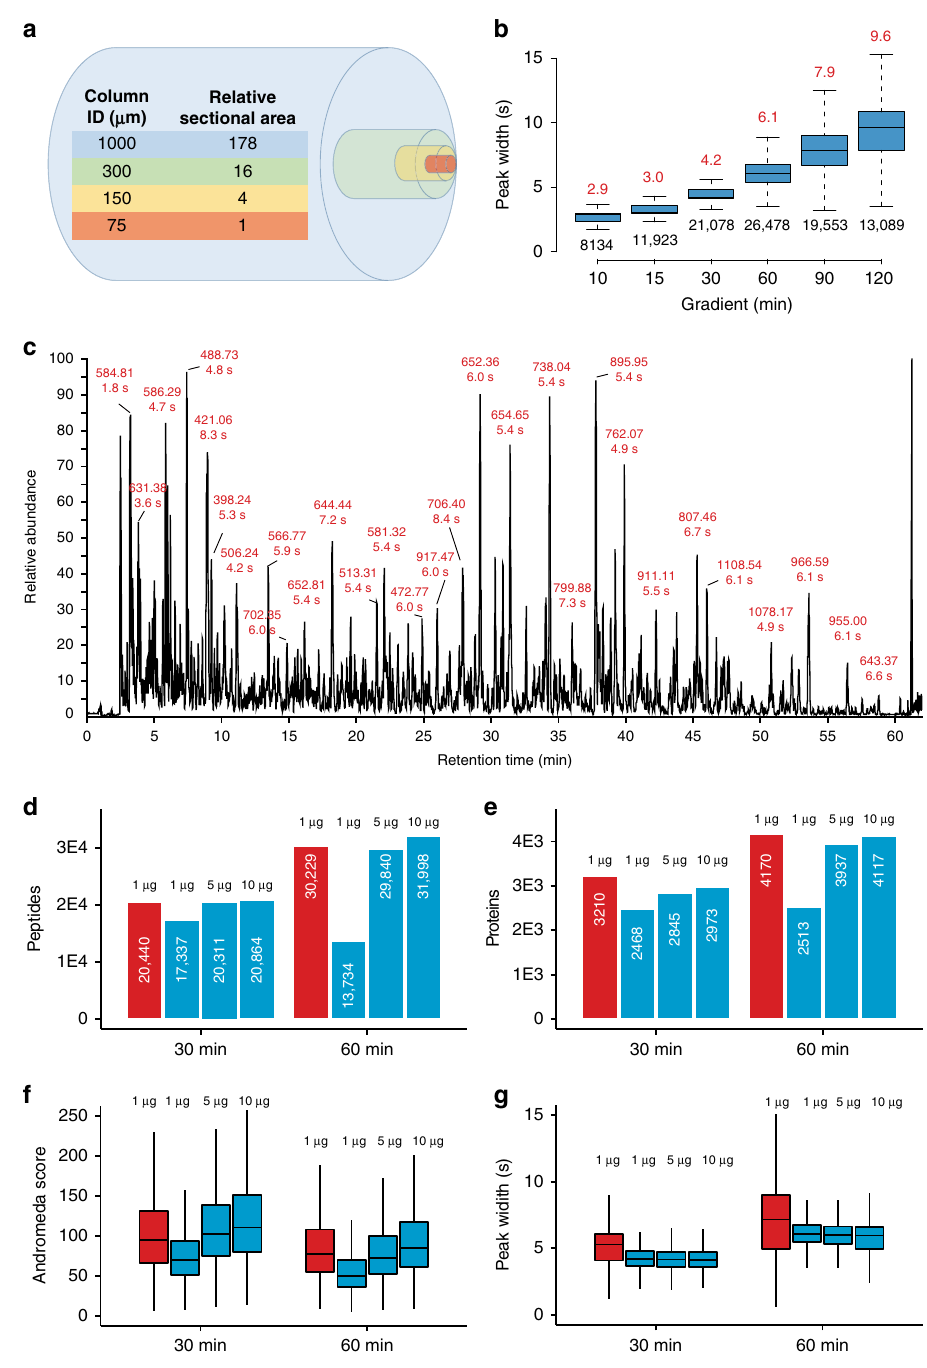
Fig. 1 Qualitative performance characteristics of the micro- fl ow LC – MS/MS system. a Comparison of the cross-sectional areas of LC columns of different inner diameters (ID). b Boxplots summarizing the chromatographic peak width distributions (full width at half-maximum, FWHM) of all identi fi ed peptides for different LC gradient times (2 µ g HeLa protein digest injected). Boxes and whiskers cover 50% and 1.5 times the interquartile range of the data respectively. Numbers above boxes denote the median FWHM values (in seconds), numbers below boxes represent the number of peptides contained in the analysis. c Example base peak chromatogram of 2 µ g HeLa protein digest separated by a 60 min LC gradient. Selected chromatographic peaks are labeled with the m/z and FWHM values of the underlying peptide. d Bar charts comparing peptide identi fi cation results obtained for different sample loadings and LC gradient times using either nano- fl ow 29, 31 (red) or micro- fl ow LC – MS/MS (blue). White numbers inside bars denote the number of peptides. e Same as panel d but for proteins. f Box plots comparing Andromeda peptide identi fi cation scores obtained for different sample loadings and LC gradient times using either nano- fl ow (red, n = 24,113 for 30 min, 36,442 for 60 min) or micro- fl ow (blue, n = 19,514 (1 µ g), 23,047 (5 µ g), and 23,630 (10 µ g) for 30 min, and n = 14,992 (1 µ g), 34,356 (5 µ g), and 37,130 (10 µ g) for 60 min) LC – MS/MS. g Same as panel f but for peptide chromatographic peak widths. The number of peaks used for each box are 22,254 (nano), 19,104 (micro, 1 µ g), 21,820 (micro, 5 µ g), and 22,065 (micro, 10 µ g) for 30 min, and 33,772 (nano), 12,831 (micro, 1 µ g), 32,835 (micro, 5 µ g), and 34,884 (micro, 10 µ g) for 60 min. Boxes and whiskers are de fi ned as in b . Source data are provided as a Source Data fi le for b , f , and g